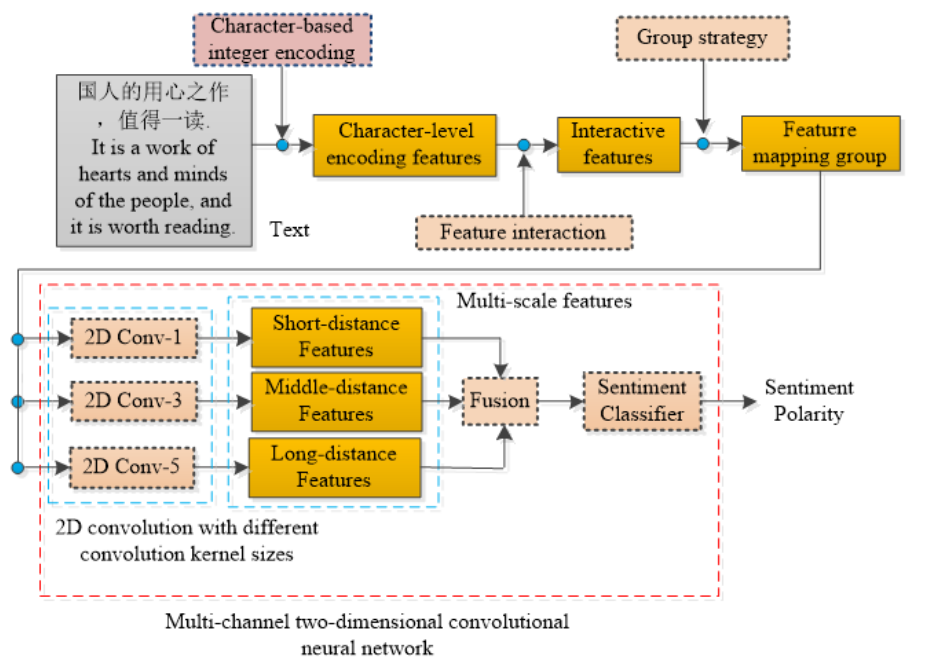
Figure 1. The framework of MCNN-IFGS. Here, 2D Conv-1 represents 2D-CNN with a size of 1*1 convolution kernel and so on.